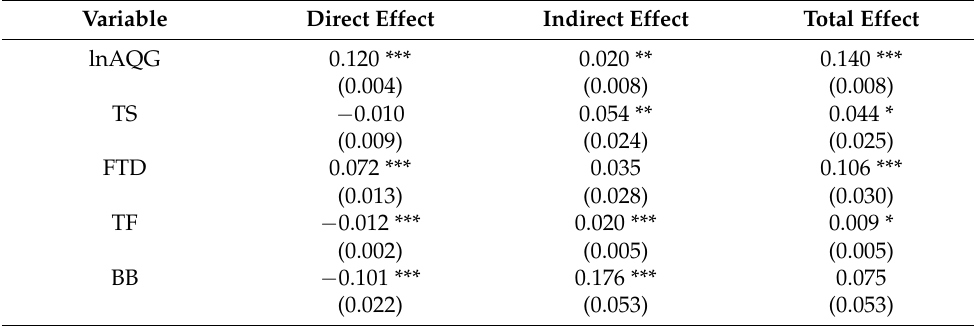
Table 4. Decomposition effect of air pollution